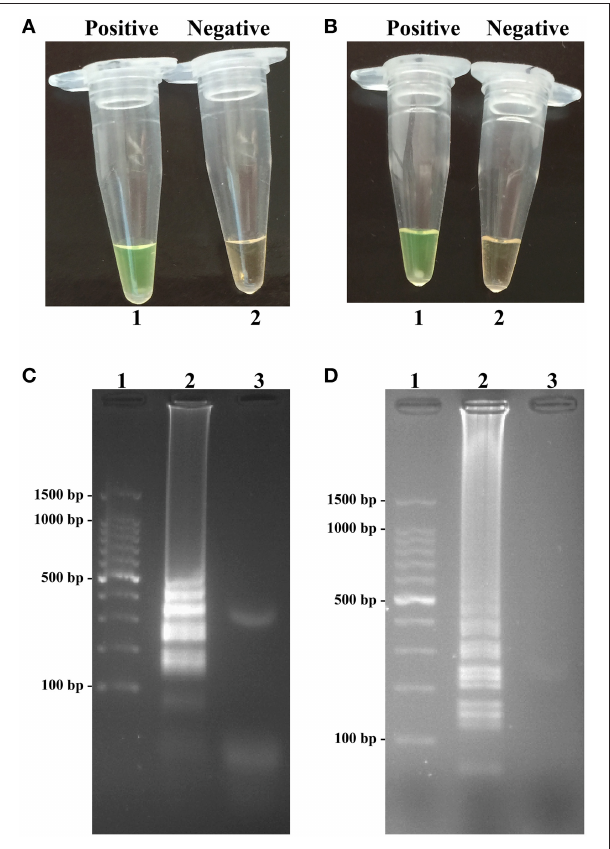
FIGURE 2 | Confirmation and detection of Shigella - and Salmonella -LAMP products. (A,B) Color change of Shigella - and Salmonella -LAMP tubes; tube 1, positive amplification; tube 2, negative amplification. (C,D) , 2% agarose gel electrophoresis applied to Shigella - and Salmonella -LAMP products; lane 1, DL 100-bp DNA marker; lane 2, positive LAMP reaction, lane 3, negative LAMP reaction.